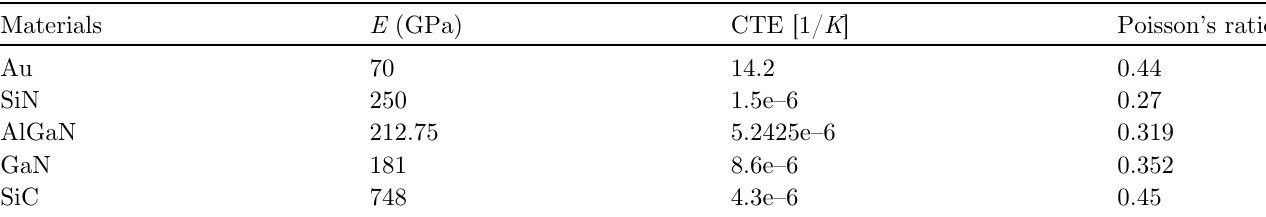
Table 2. Material ’ s physical properties.